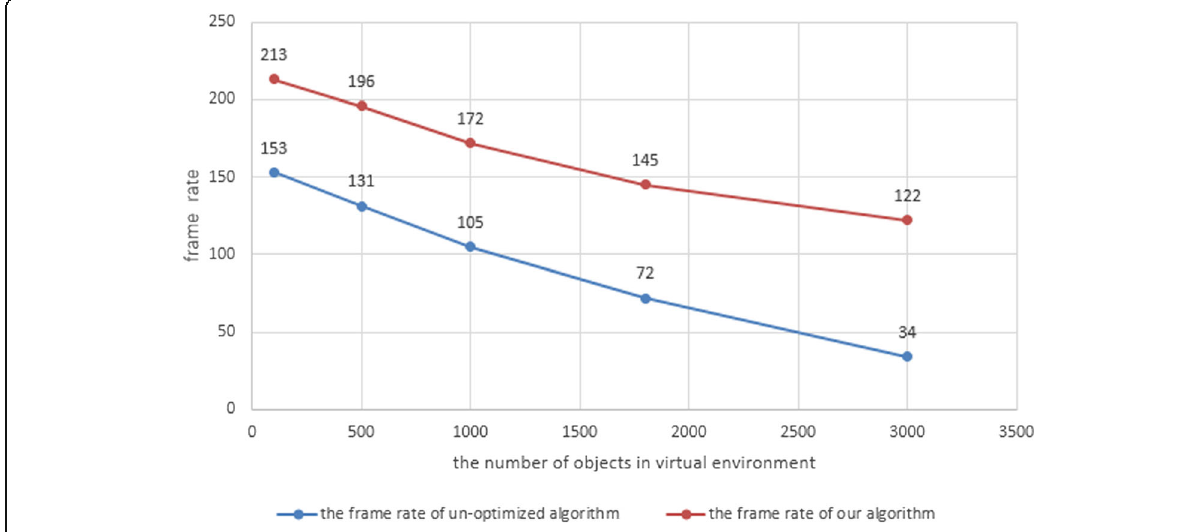
Fig. 8 The frame rate of our algorithm compared with un-optimized algorithm